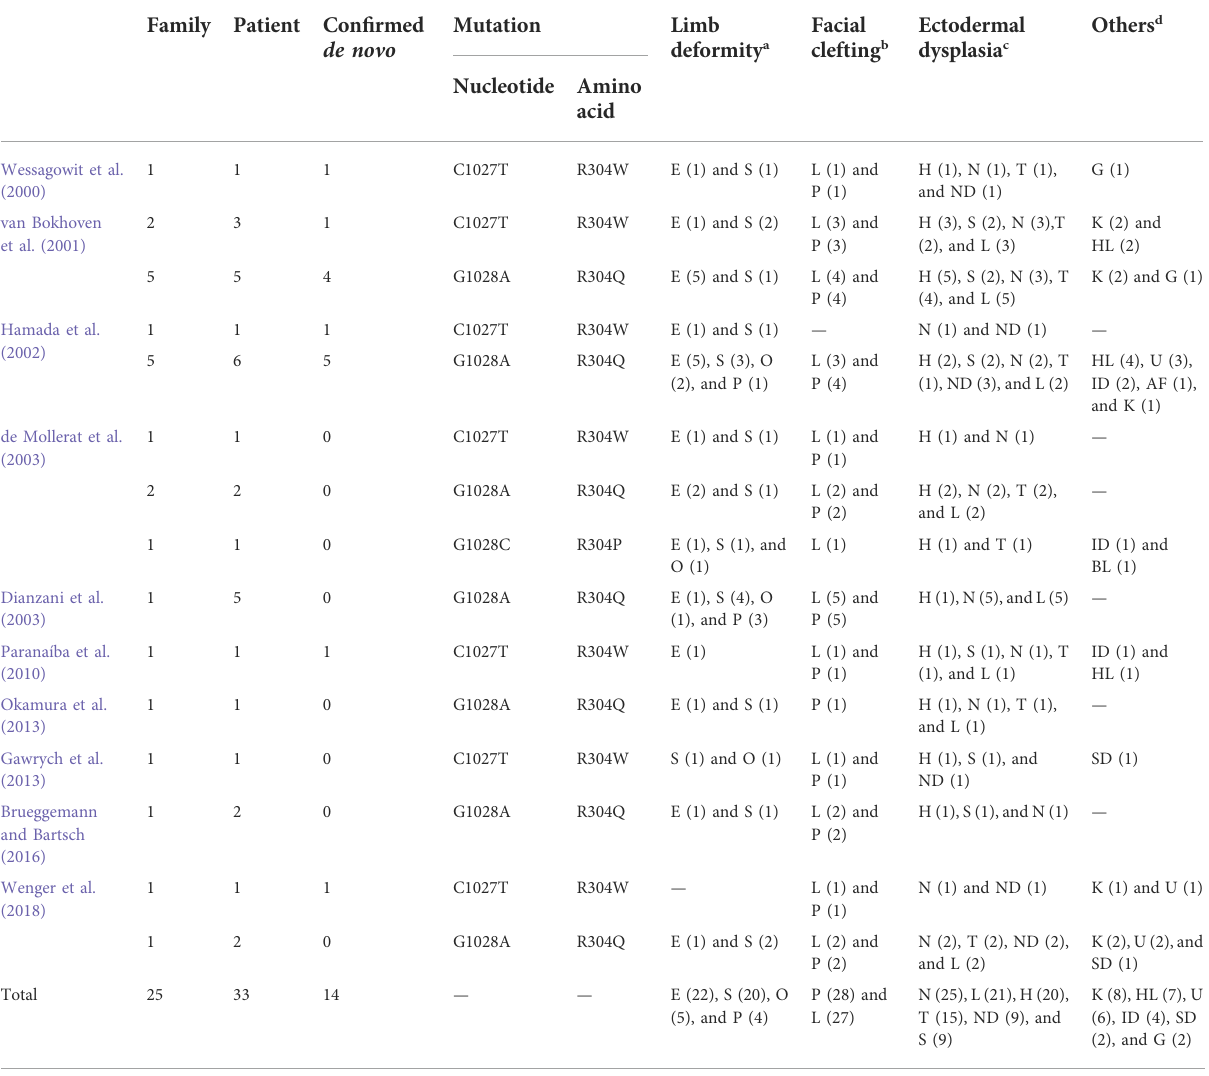
TABLE 1 Phenotypic characteristics of EEC syndrome associated with R304